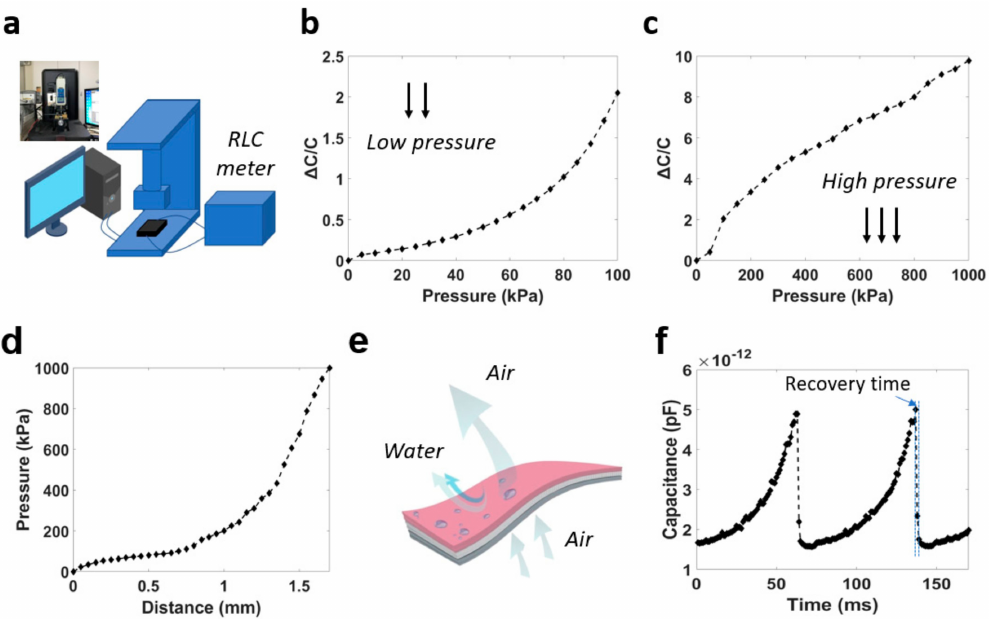
Figure 5. ( a ) Universal testing machine (UTM), ( b ) relative change in capacitance under pressure from 0 to 100 kPa, ( c ) relative change in the capacitance under pressure from 0 to 1000 kPa, ( d ) relative change in the compression distance under pressure from 0 to 1000 kPa, ( e ) breathable ability, ( f ) response / recovery time, and (change the numerical order of